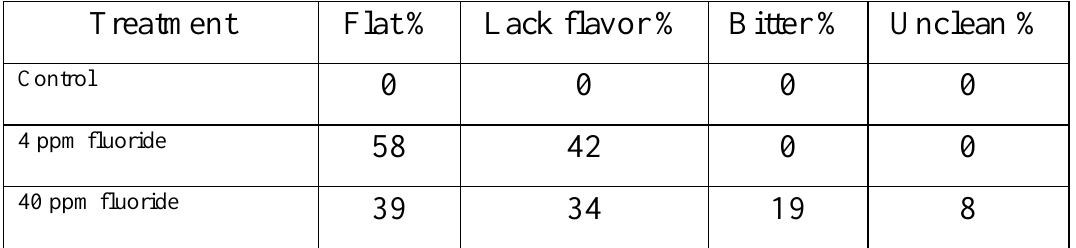
Table (2): Effect of fluoride on flavor criticisms of Cheddar cheese after 120 days.